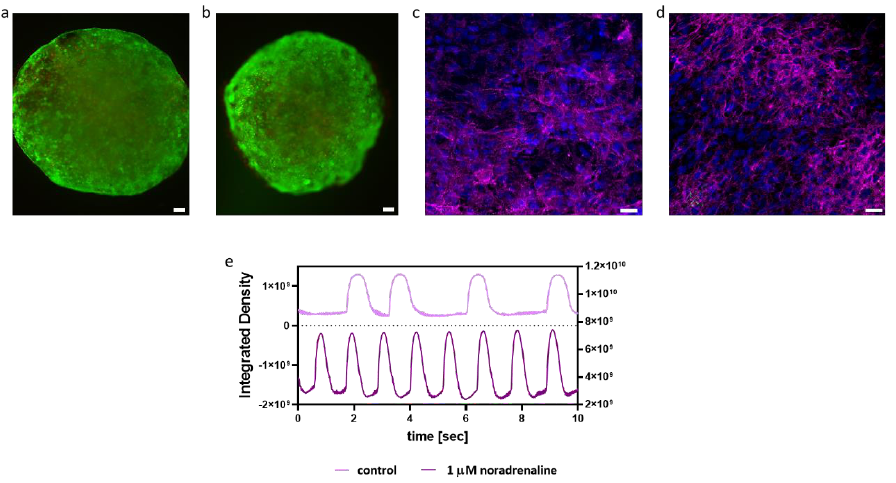
Figure 4. Engineered cardiac implants within the nanocomposite hydrogel. ( a , b ) Viability test within the nanocomposite ( a ) and pristine hydrogels ( b ), 1 week post encapsulation; scale bar = 100 µm. ( c , d ) Cardiac sarcomeric actinin immunostaining of the nanocomposite implants on day 7 ( c ) and day 14 ( d ). Actinin in pink, nuclei in blue; scale bar = 25 µm. ( e ) Contraction rate of the nanocomposite implant before and after the addition of 1 µM noradrenaline.